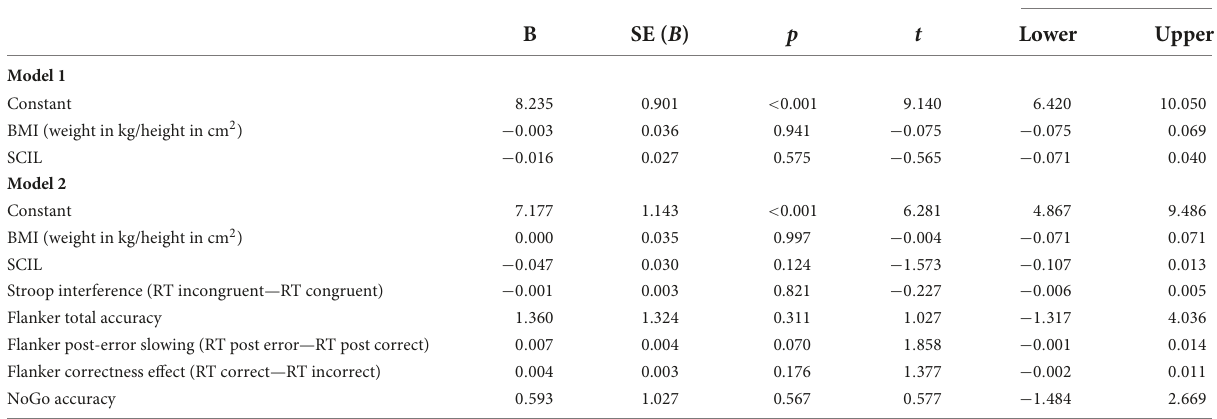
TABLE 2 Results of linear regression examining free-living physical activity and cognitive control in multi-problem young adults ( N =